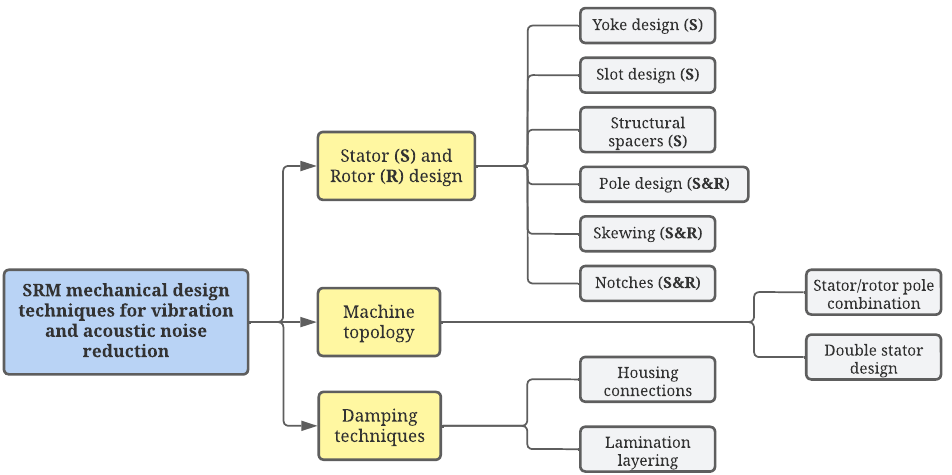
Figure 1. Overview of mechanical design techniques for vibration and acoustic noise reduction.